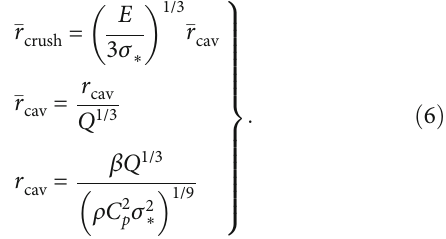
Figure 2: Waveform of the stress curve outside the crushing